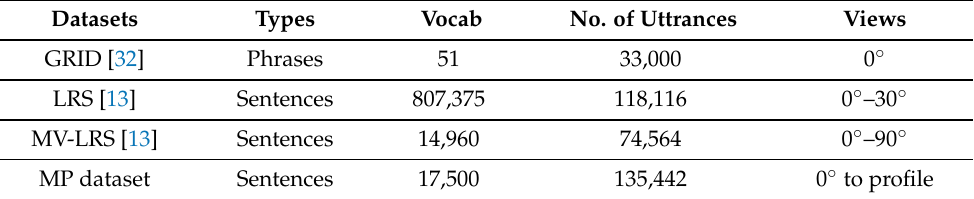
Table 2. Vocabulary size with corresponding views in the existing and proposed dataset.